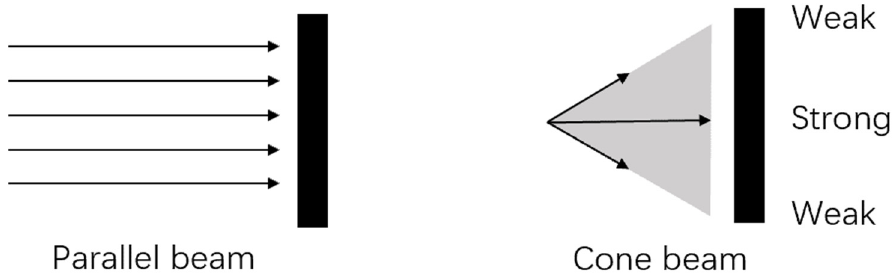
Figure 13. Parallel beam vs. cone beam in the dose regarding location.